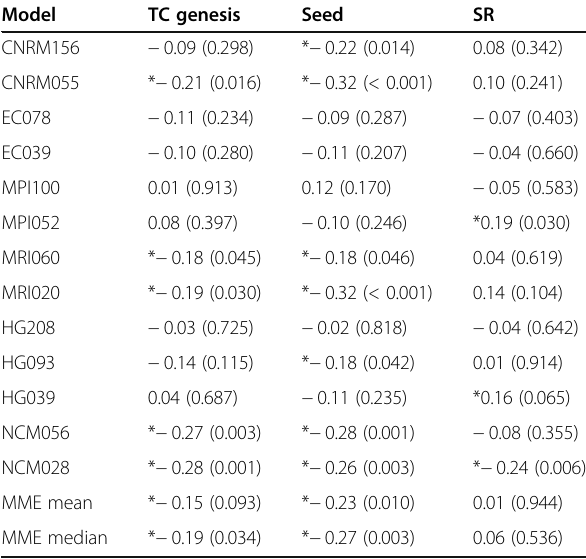
Table 3 Trends in TC genesis, TC seed frequency, and survival rate (SR). Trends were calculated from 1990 to 2049. An asterisk indicates that a trend is statistically significant at the 90% confidence level (at least) with the nonparametric Mann – Kendal test. P values are indicated in parentheses